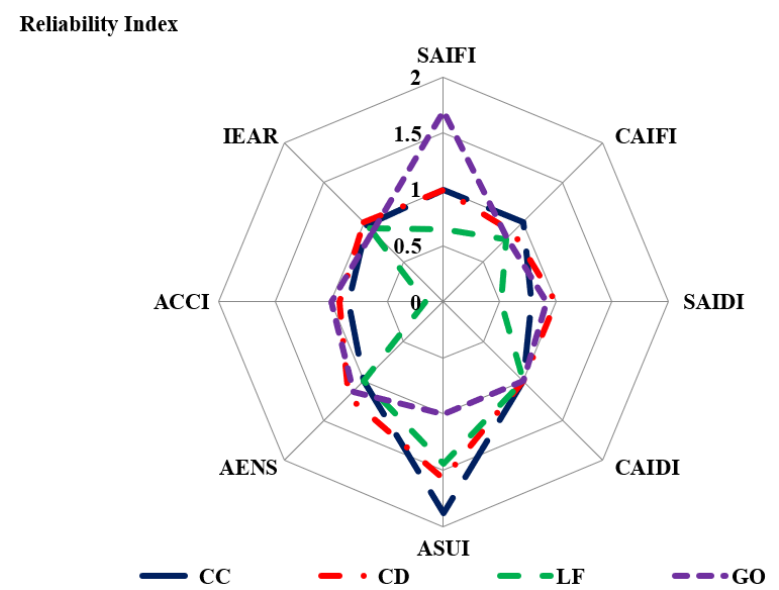
Figure 8. Reliability index parameters according to four dispatch strategies.